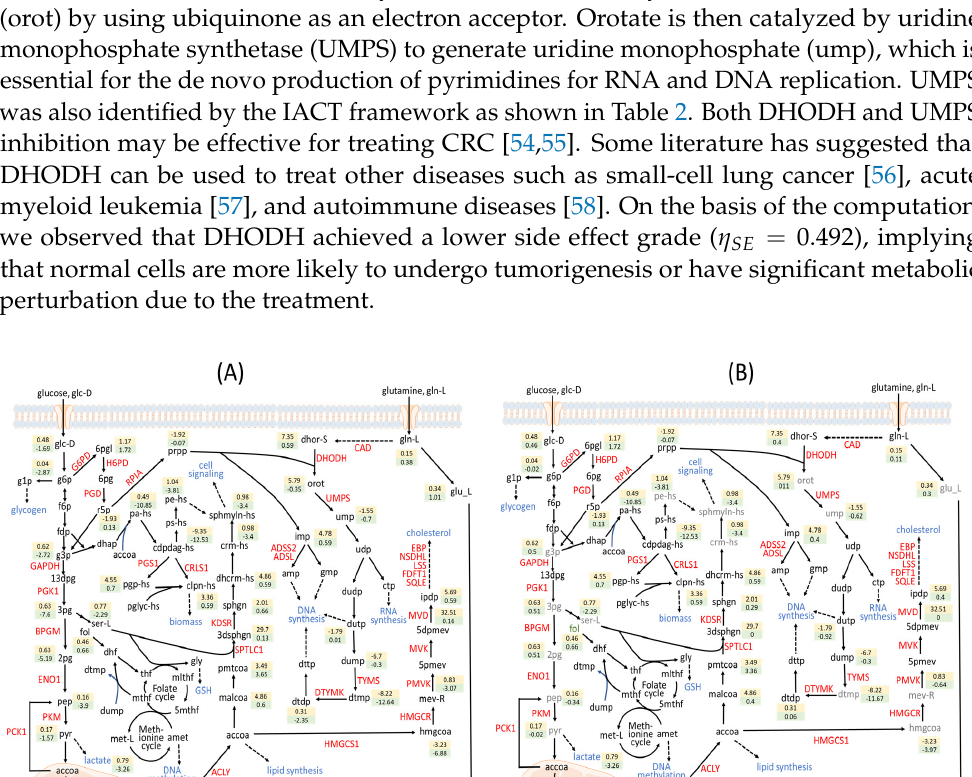
2 fold changes of metabolite-flows 2 BL ( r MU a ) for each perturbation. m / r m 2